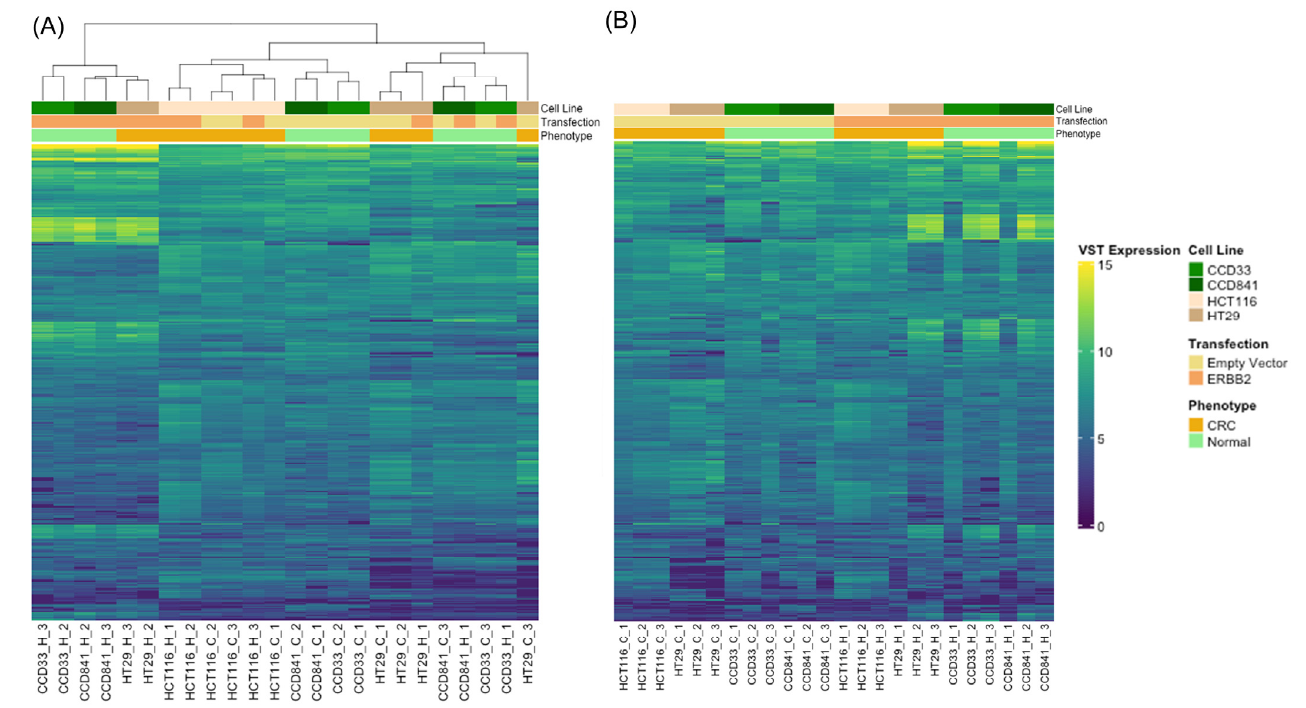
Figure 2. Heatmap of the differentially expressed genes in CRC (HCT116 and HT29) and normal colon (CCD33 and CCD841) cell lines transfected with empty vector or ERBB2, either clustered based on expression ( A ) or grouped based on transfection and phenotype ( B ).